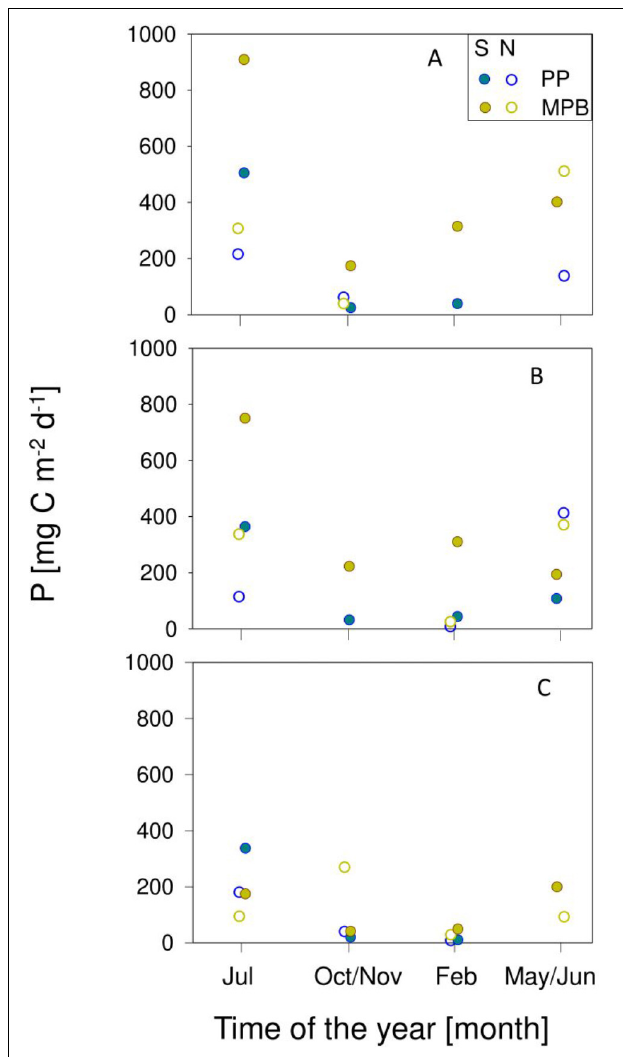
FIGURE 9 | Seasonal variation of daily rates of primary production of phytoplankton (PP) and microphytobenthos (MPB) during spring (S) and neap (N) tides in sampling sites Torreira (A) , Gafanha da Encarnação (B) , and Vista Alegre (C) .